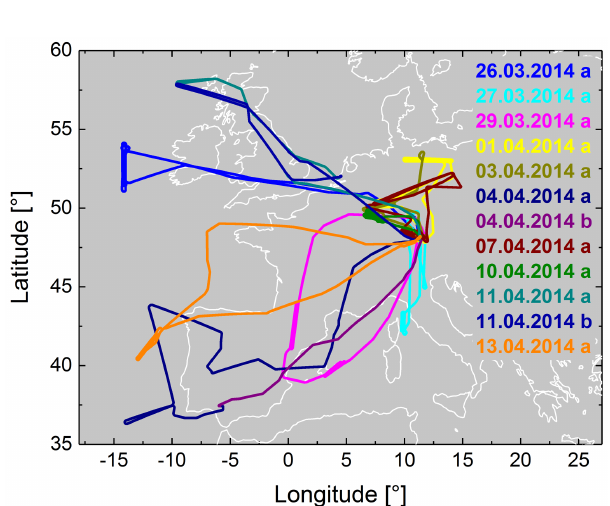
Figure 1. Flight tracks of 12 research flights during the ML- CIRRUS campaign in March/April 2014 used for this study. Lat- itudes between 36 and 57 ◦ N were covered mainly over central and western